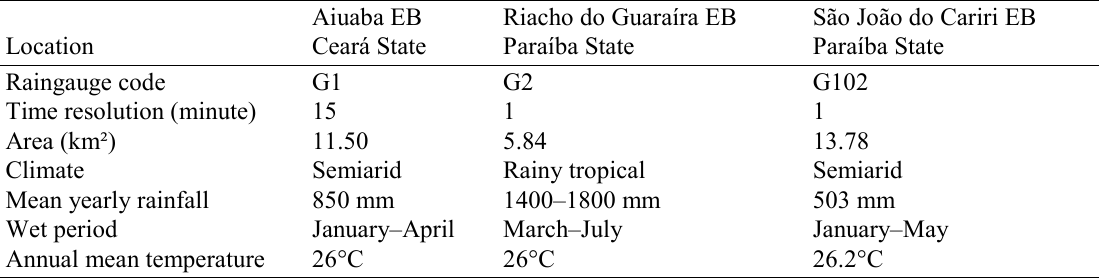
Table 1 Main characteristics of three experimental basins.